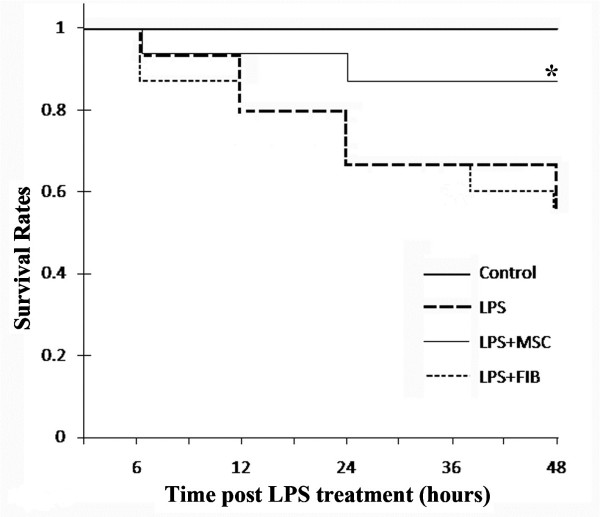
The survival rate of the LPS + MSC group over 48 hours is significantly higher than that of the LPS group (87% vs 60%; * p < 0.05). UC-MSCs treatment improved survival rates at all time-points.